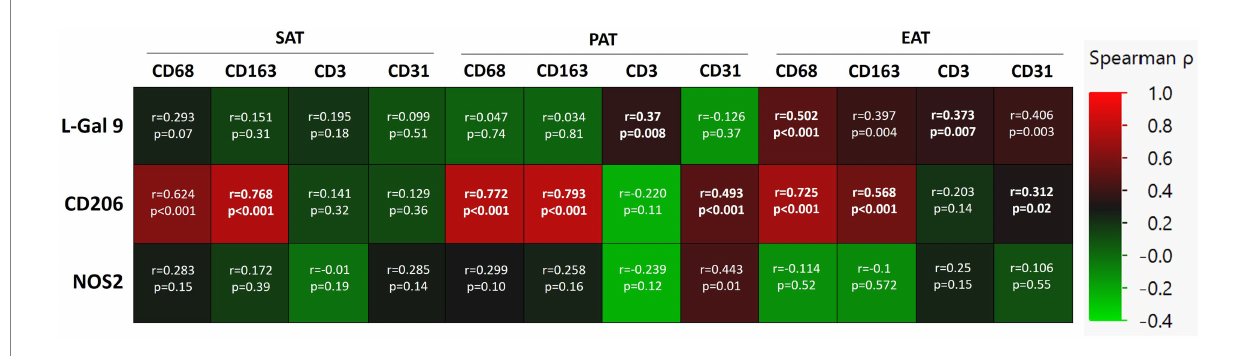
FIGURE 3 Correlations between L-Gal 9, CD206, and NOS2 expression and the cell markers CD68, CD163, CD3, and CD31 in SAT, PAT, and EAT in CHD patients. Correlations are reported as heatmap following Spearman ρ analyses, and those still significant after Bonferroni correction (36 comparisons; p < 0.0014) are marked in bold.